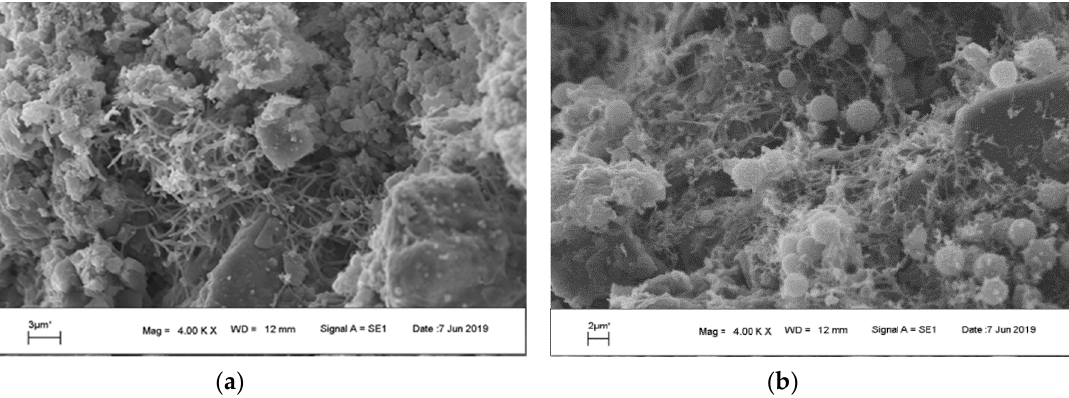
Figure 4. SEM images of lime mortar pieces: ( a ) pseudomycelium of Streptomyces ; ( b ) hyphae with spores.